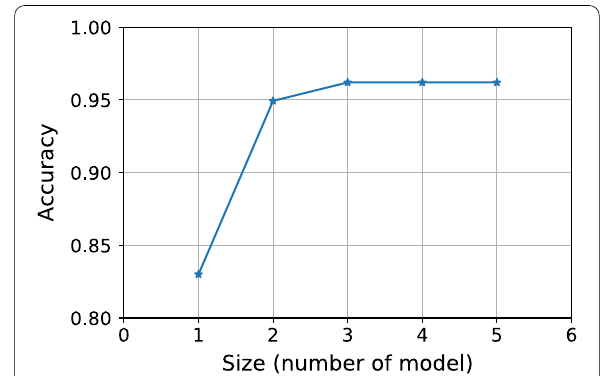
Fig. 8 Effect of the number of ensemble